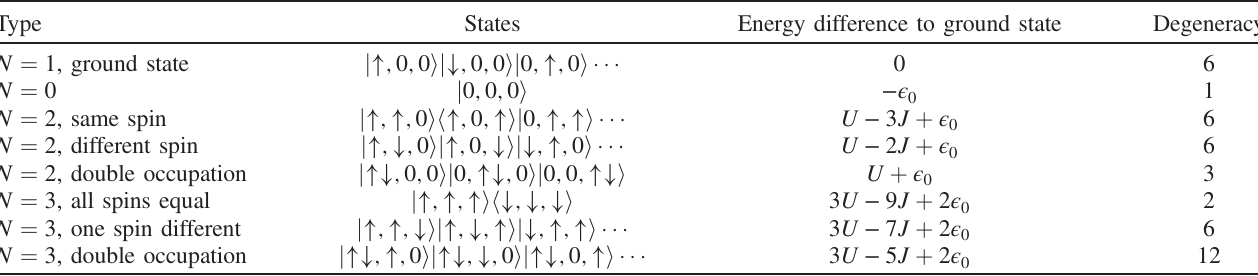
TABLE I. Relevant states of the atomic problem of Hamiltonian (1) without spin-flip and pair-hopping terms. Type